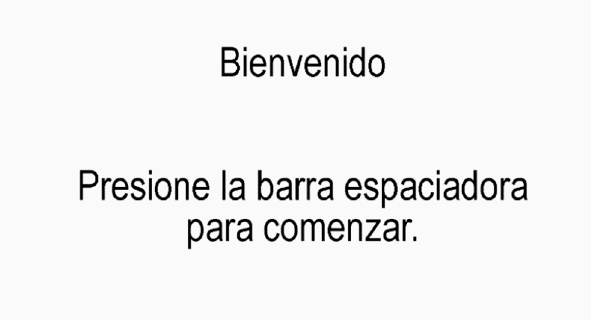
Figure 6. Initial screen.